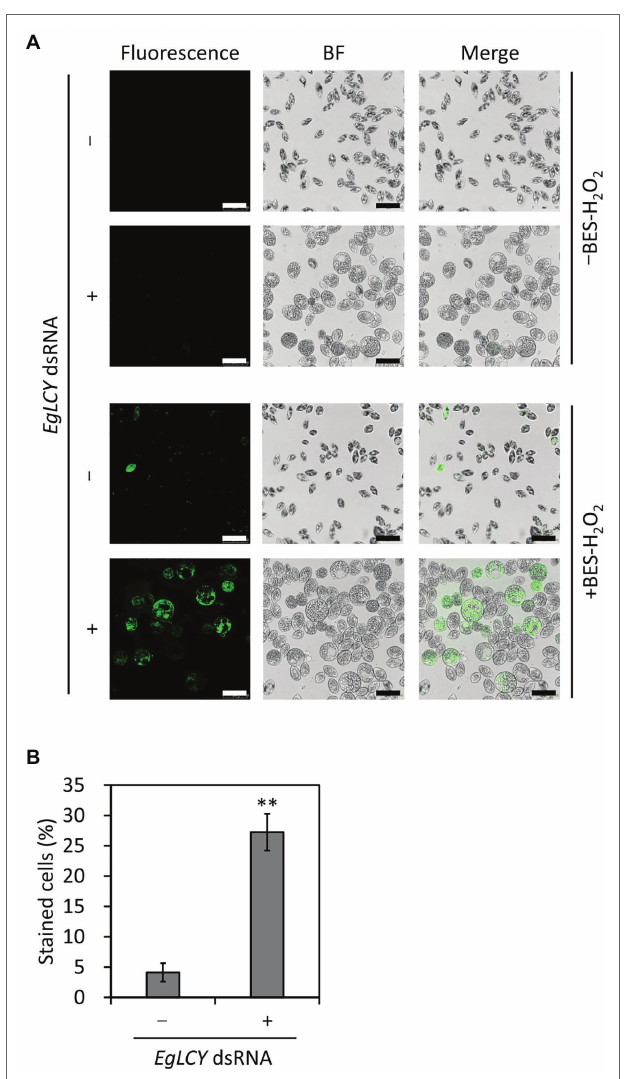
FIGURE 8 | Effect of EgLCY suppression on cellular H 2 O 2 levels. Cells treated with or without EgLCY dsRNA were mixotrophically grown under continuous light (40 μ mol photons m − 2 s − 1 ) at 25 ° C for 6 d. (A) Fluorescent and bright field (BF) images of cells treated with or without EgLCY dsRNA. Cells were incubated with or without 20 μ m BES-H 2 O 2 -Ac at room temperature for 30 min. Fluorescence was observed by confocal microscopy with a 485 nm laser and emission at 490–580 nm. Scale bars are 50 μ m. (B) The staining rates of cells treated with or without EgLCY dsRNA. The criteria for staining are explained in Supplementary Figure 5 . Values are presented as the mean ± SD ( n = 3). More than 300 cells were included in each measurement. Values with asterisks are significantly different from cells treated without dsRNA according to the t -test (** p <